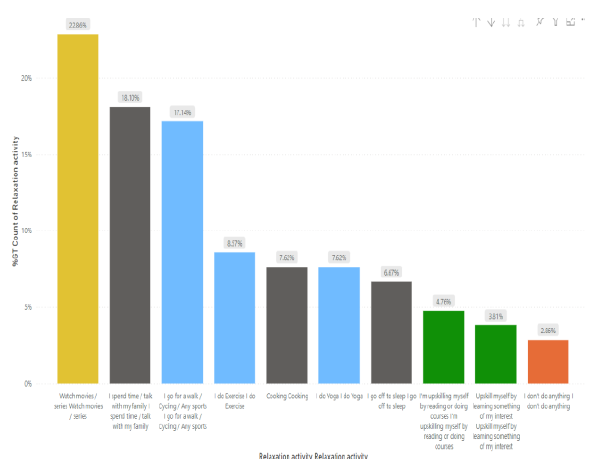
Fig. 7. Relaxation practices followed by people